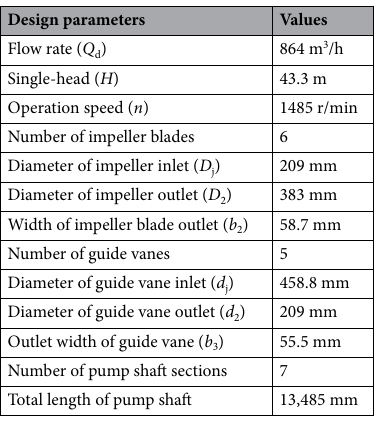
Table 1. Basic parameters of the VLSFP